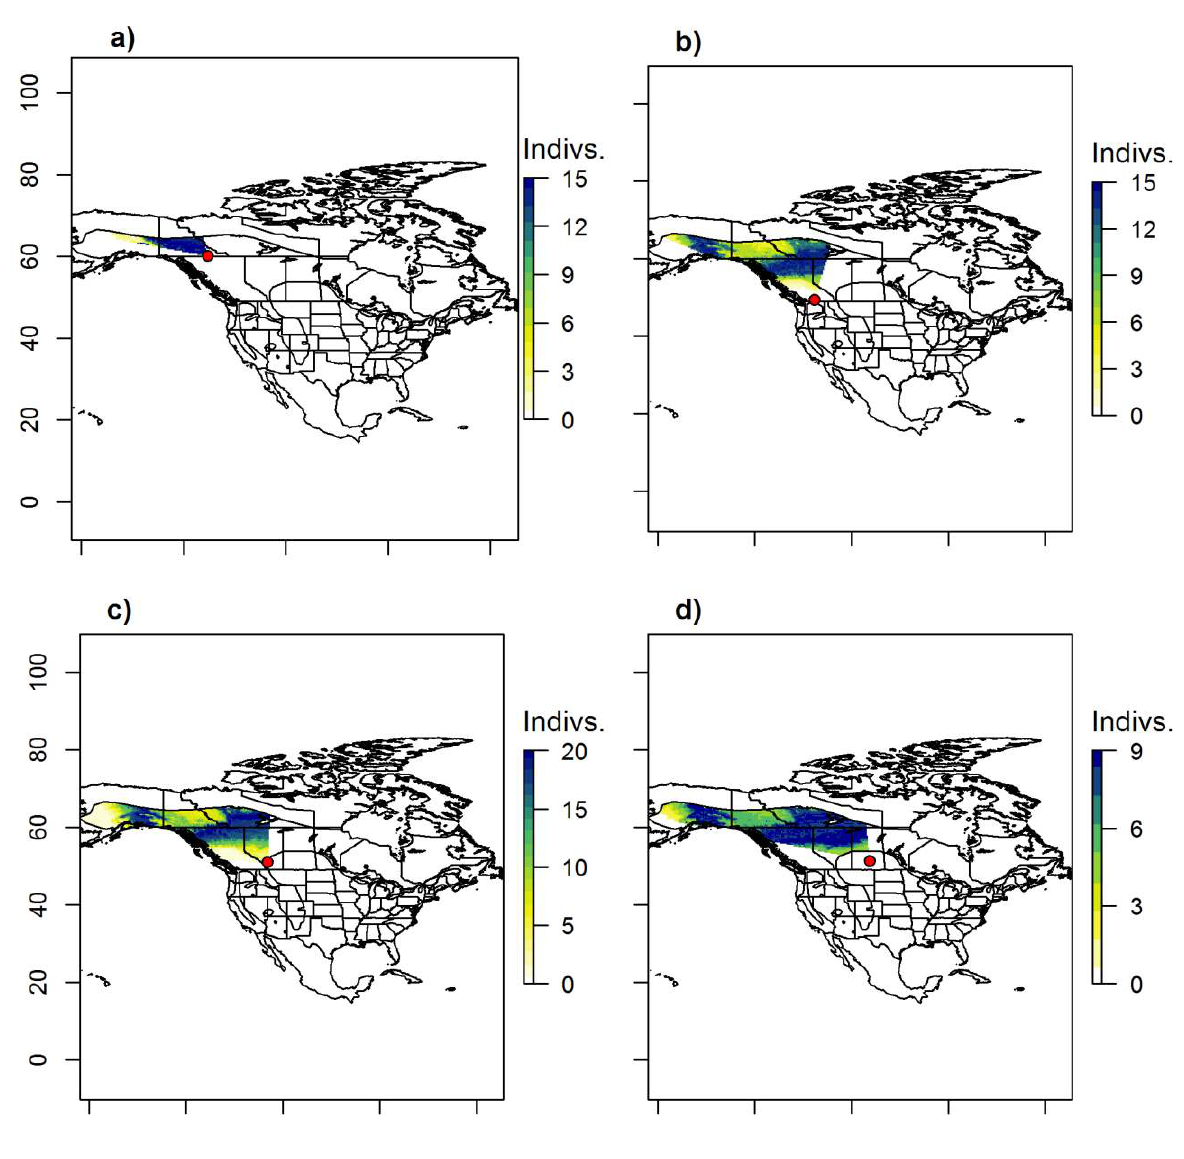
Figure A2.23: Probable origins of Lincoln’s Sparrows ( Melospiza lincolnii ) captured during fall migration at CMMN stations in a) the Yukon (ACBO (n=20)); b) Southern British Columbia (VLBO (n=20)); c) Southern Alberta (IBS (n=25)); d) Saskatchewan (LMBO (n=15)); e) Western Ontario (TCBO (n=20)); f) Southwest Ontario (BPBO (n=7), HBO (n=2), LPBO (n=5), TTPBRS (n=5)); and g) Southeast Ontario & Southwest Québec (MBO (n=15), PEPTBO